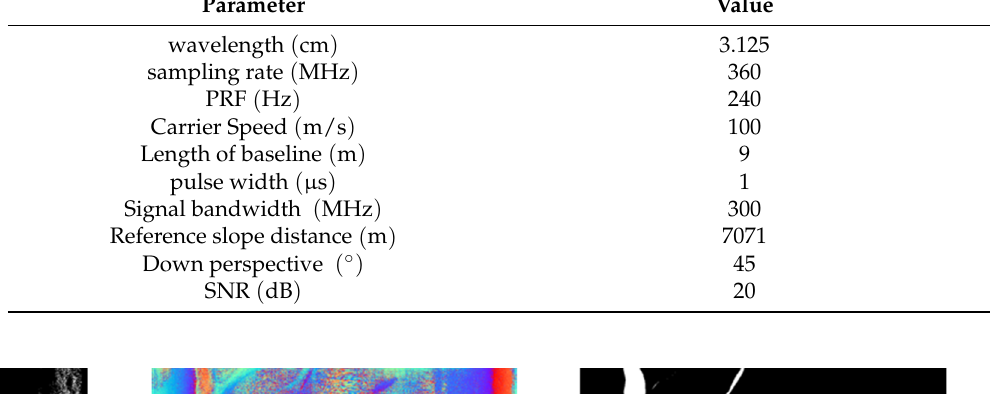
Table 1. The simulation parameters of the multi-channel array SAR.